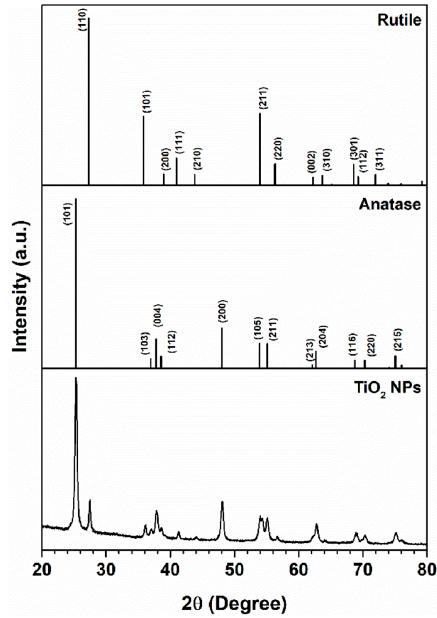
Figure 1. X ‐ ray powder diffraction (XRD) patterns for TiO 2 NP. The vertical bars correspond to the diffraction peaks attributed to TiO 2 tetragonal phases: anatase (ICDDPDF file no. 03 ‐ 065 ‐ 5714) and rutile (ICDDPDF file no. 04 ‐ 008 ‐ 7850).